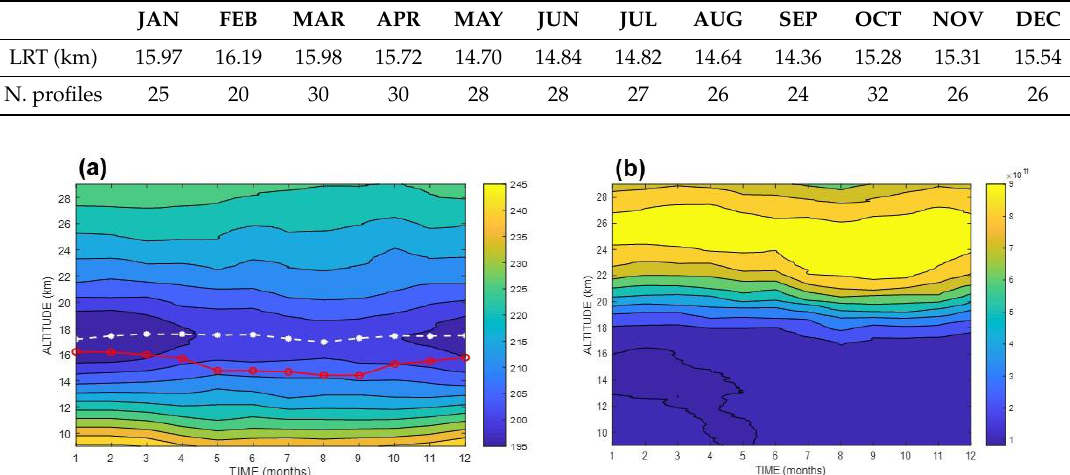
Figure 3. Vertical distribution of ozone concentration recorded on 15 February 2017 by balloon-sondes (blue line) and Microwave Limb Sounder (MLS) (black line) satellite over Irene. Table 1. Monthly mean climatological heights of LRT as derived from balloon-sonde temperature observations at Irene and during the study period (1998–2017), and number of profiles used.